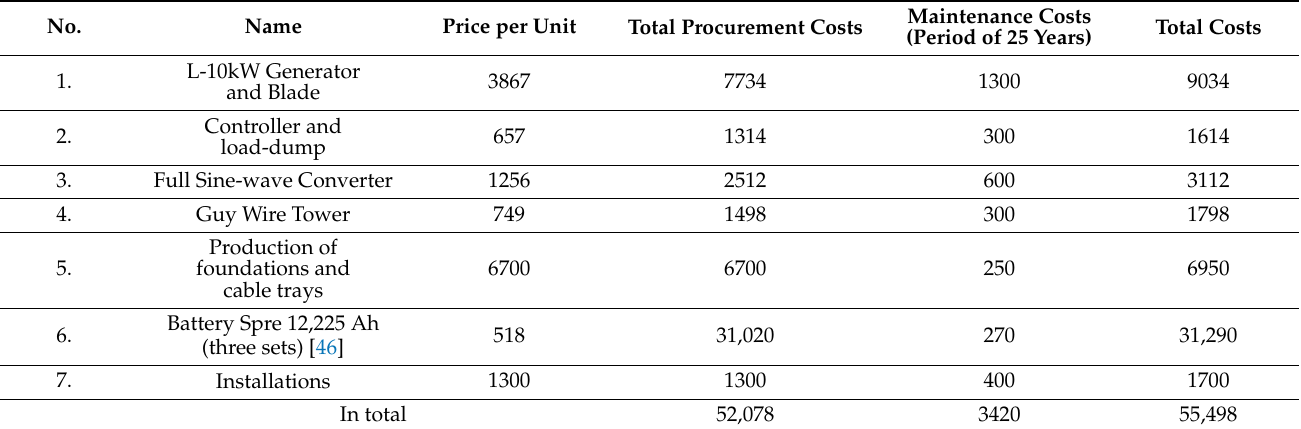
Table 4. Costs of all wind system elements are shown in €